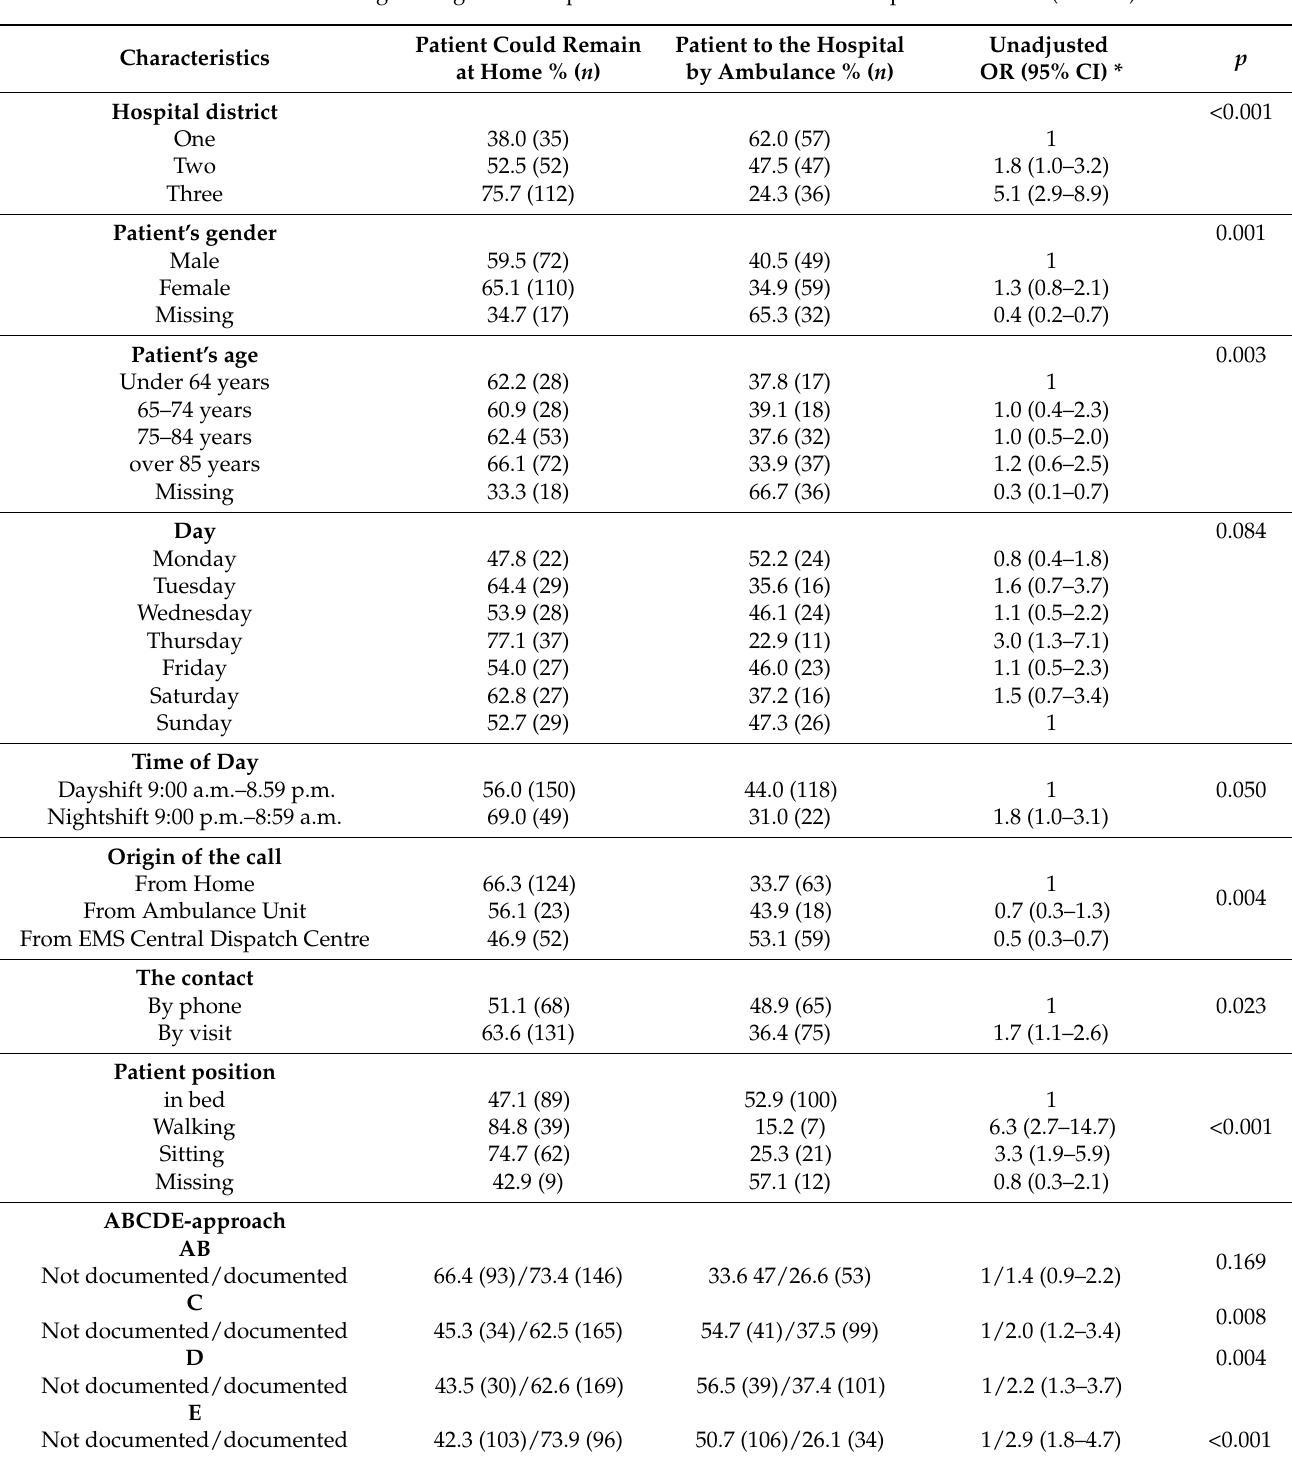
Table 4. Univariable logistic regression of predictors of CNPs’ decisions of patient at home ( n = 339).